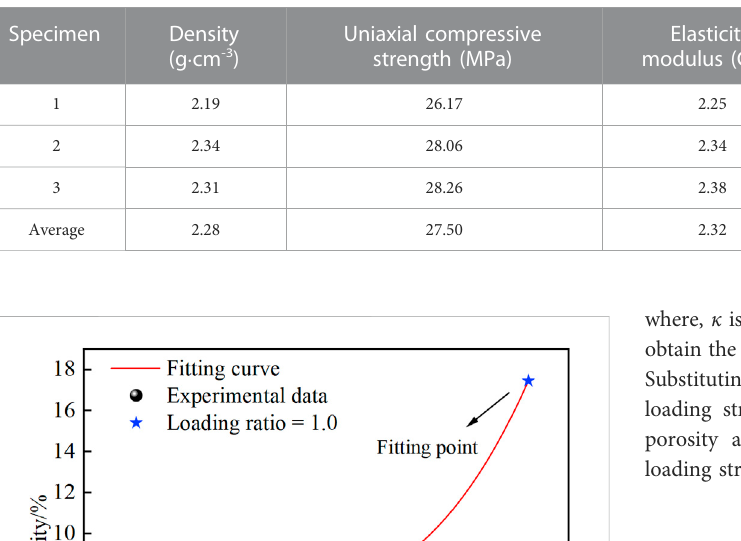
TABLE 1 Basic physical and mechanical parameters of sandstone specimens.